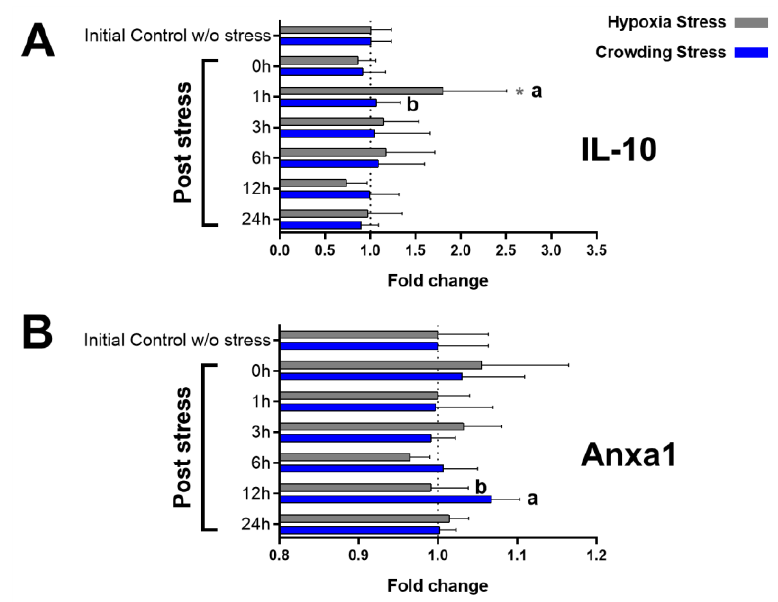
Figure 2. Plasma immunological markers by indirect ELISA (as fold of change relative to the initial control ± standard deviation). ( A ) IL-10. ( B ) Anxa1. Sampling groups: initial control group (without stress) and 0, 1, 3, 6, 12, and 24 h post-stress. In grey, hypoxia stress; in blue, crowding stress. Significant differences ( p < 0.05) are denoted with * (compared with initial control group) and with the letters a and b (compared between stress models).